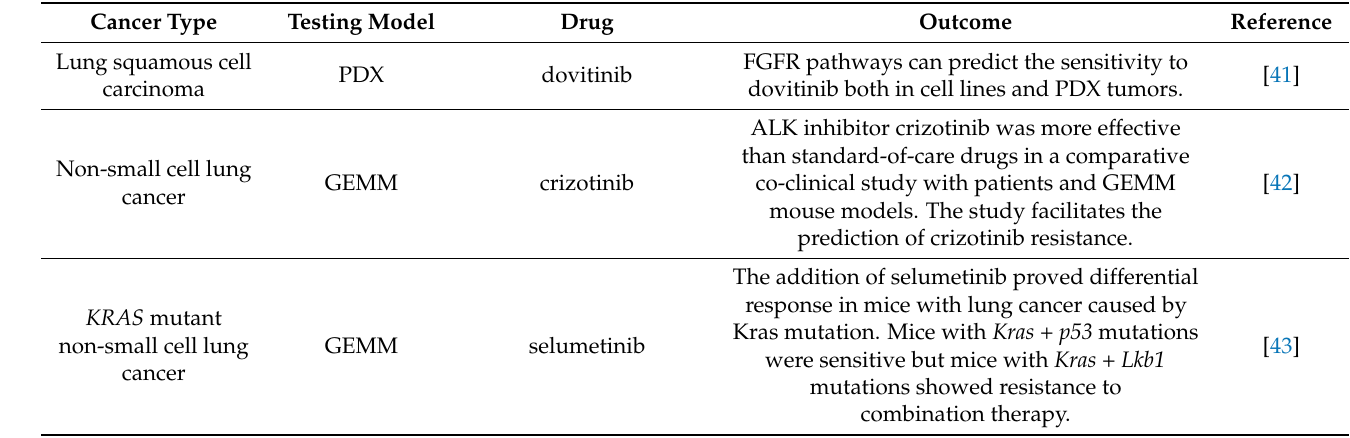
Table 1. Co-clinical trials in